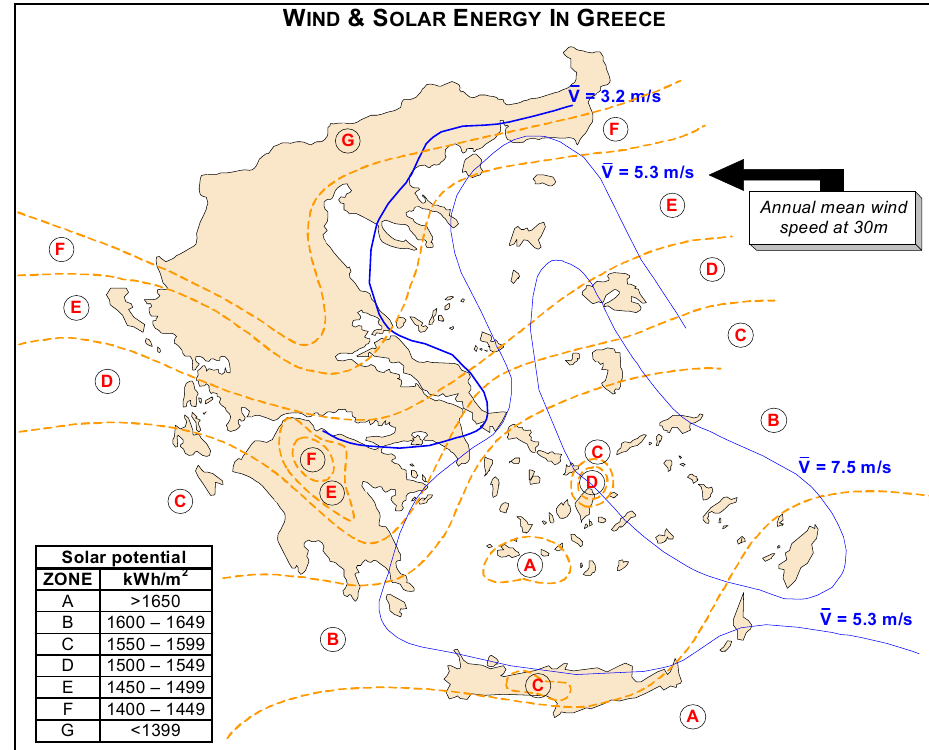
Figure 2. Wind & Solar Potential in Aegean Sea.